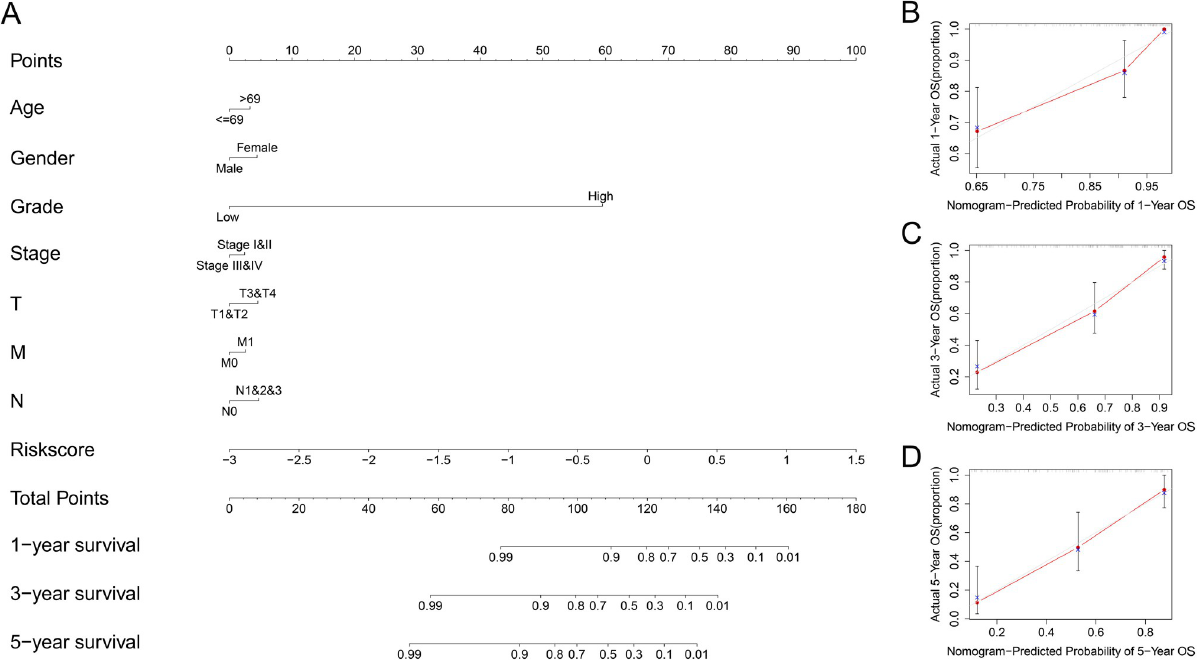
Fig 4. Establishment of the nomogram in TCGA. The results of the nomogram (A) and the calibration curve appropriately predicted 1-year (B), 3-year (C) and 5-year (D) OS for BC patients in TCGA. TCGA, The Cancer Genome Atlas; OS, overall survival; BC, bladder cancer.